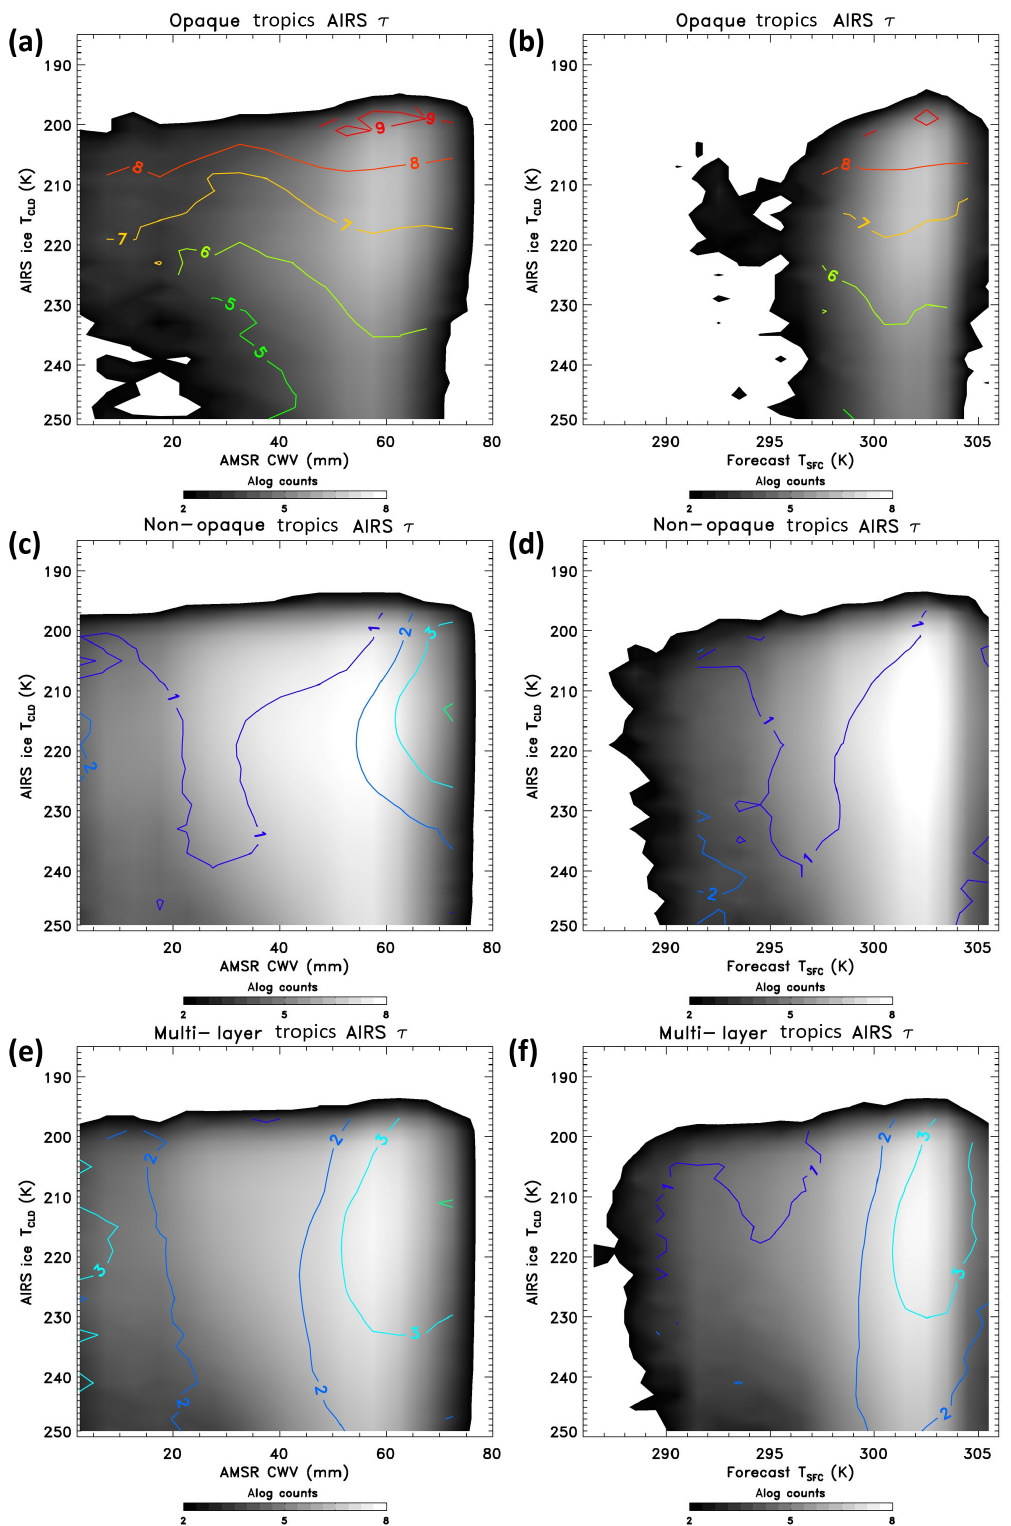
Figure 11. AMSR-E/AMSR-2 total CWV (mm) (a, c, e) or T sfc (K) (b, d, f) vs. T cld histograms. The log counts are shown as a greyscale, the AIRS IR only τ i overlaid as colored contours, with opaque (a, b) , non-opaque (c, d) , and multi-layered (e, f) clouds shown separately.